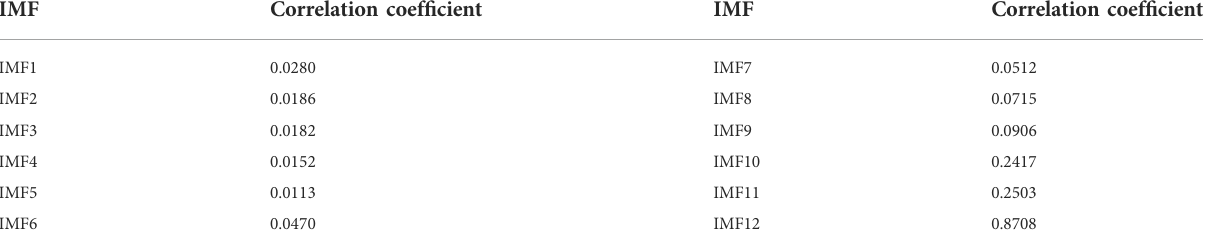
TABLE 1 Correlation coef fi cients between the IMF components and original